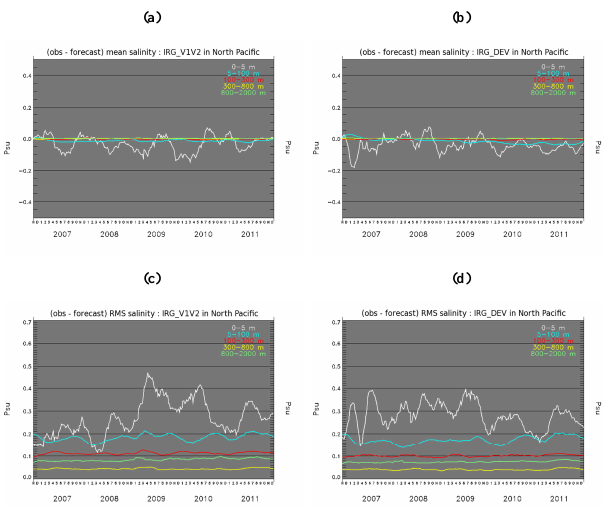
Fig. 19. Salinity data assimilation statistics in the North Pacific GODAE region, and for IRG_V1V2 ( a and c ) and IRG_DEV ( d and e ): Mean (a and b) and RMS ( c and d ) of salinity (psu) innovations (observation minus forecast) computed in layers (0-5, 5-100, 100-300, 300-800, 800-2000) and as a function of time during the 2007-2011 period. For clarity, the time series were smoothed with a 60-day running mean. These scores are averaged over all seven days of the data assimilation window, with a lead time equal to 3.5 days.